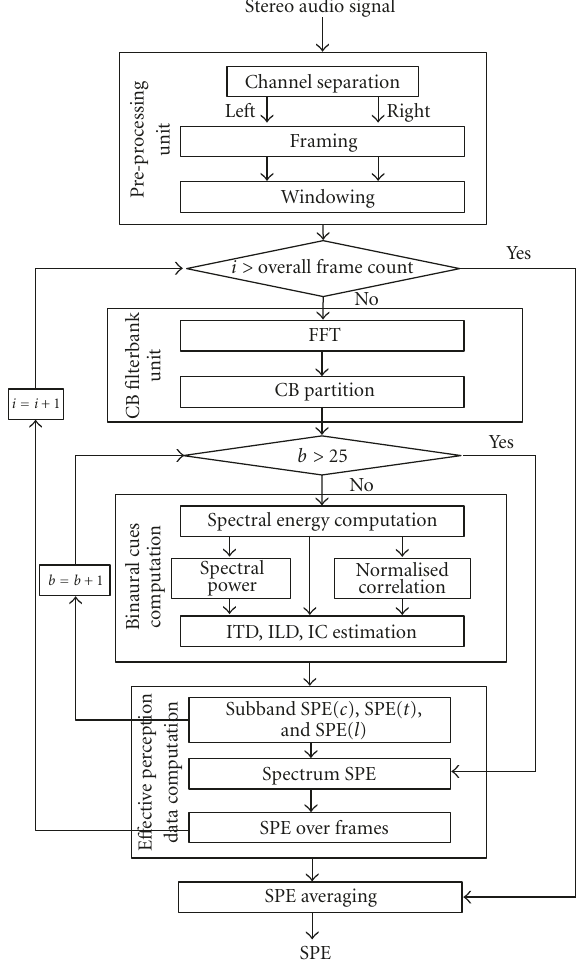
Figure 14: Flowchart of SPE Computation.